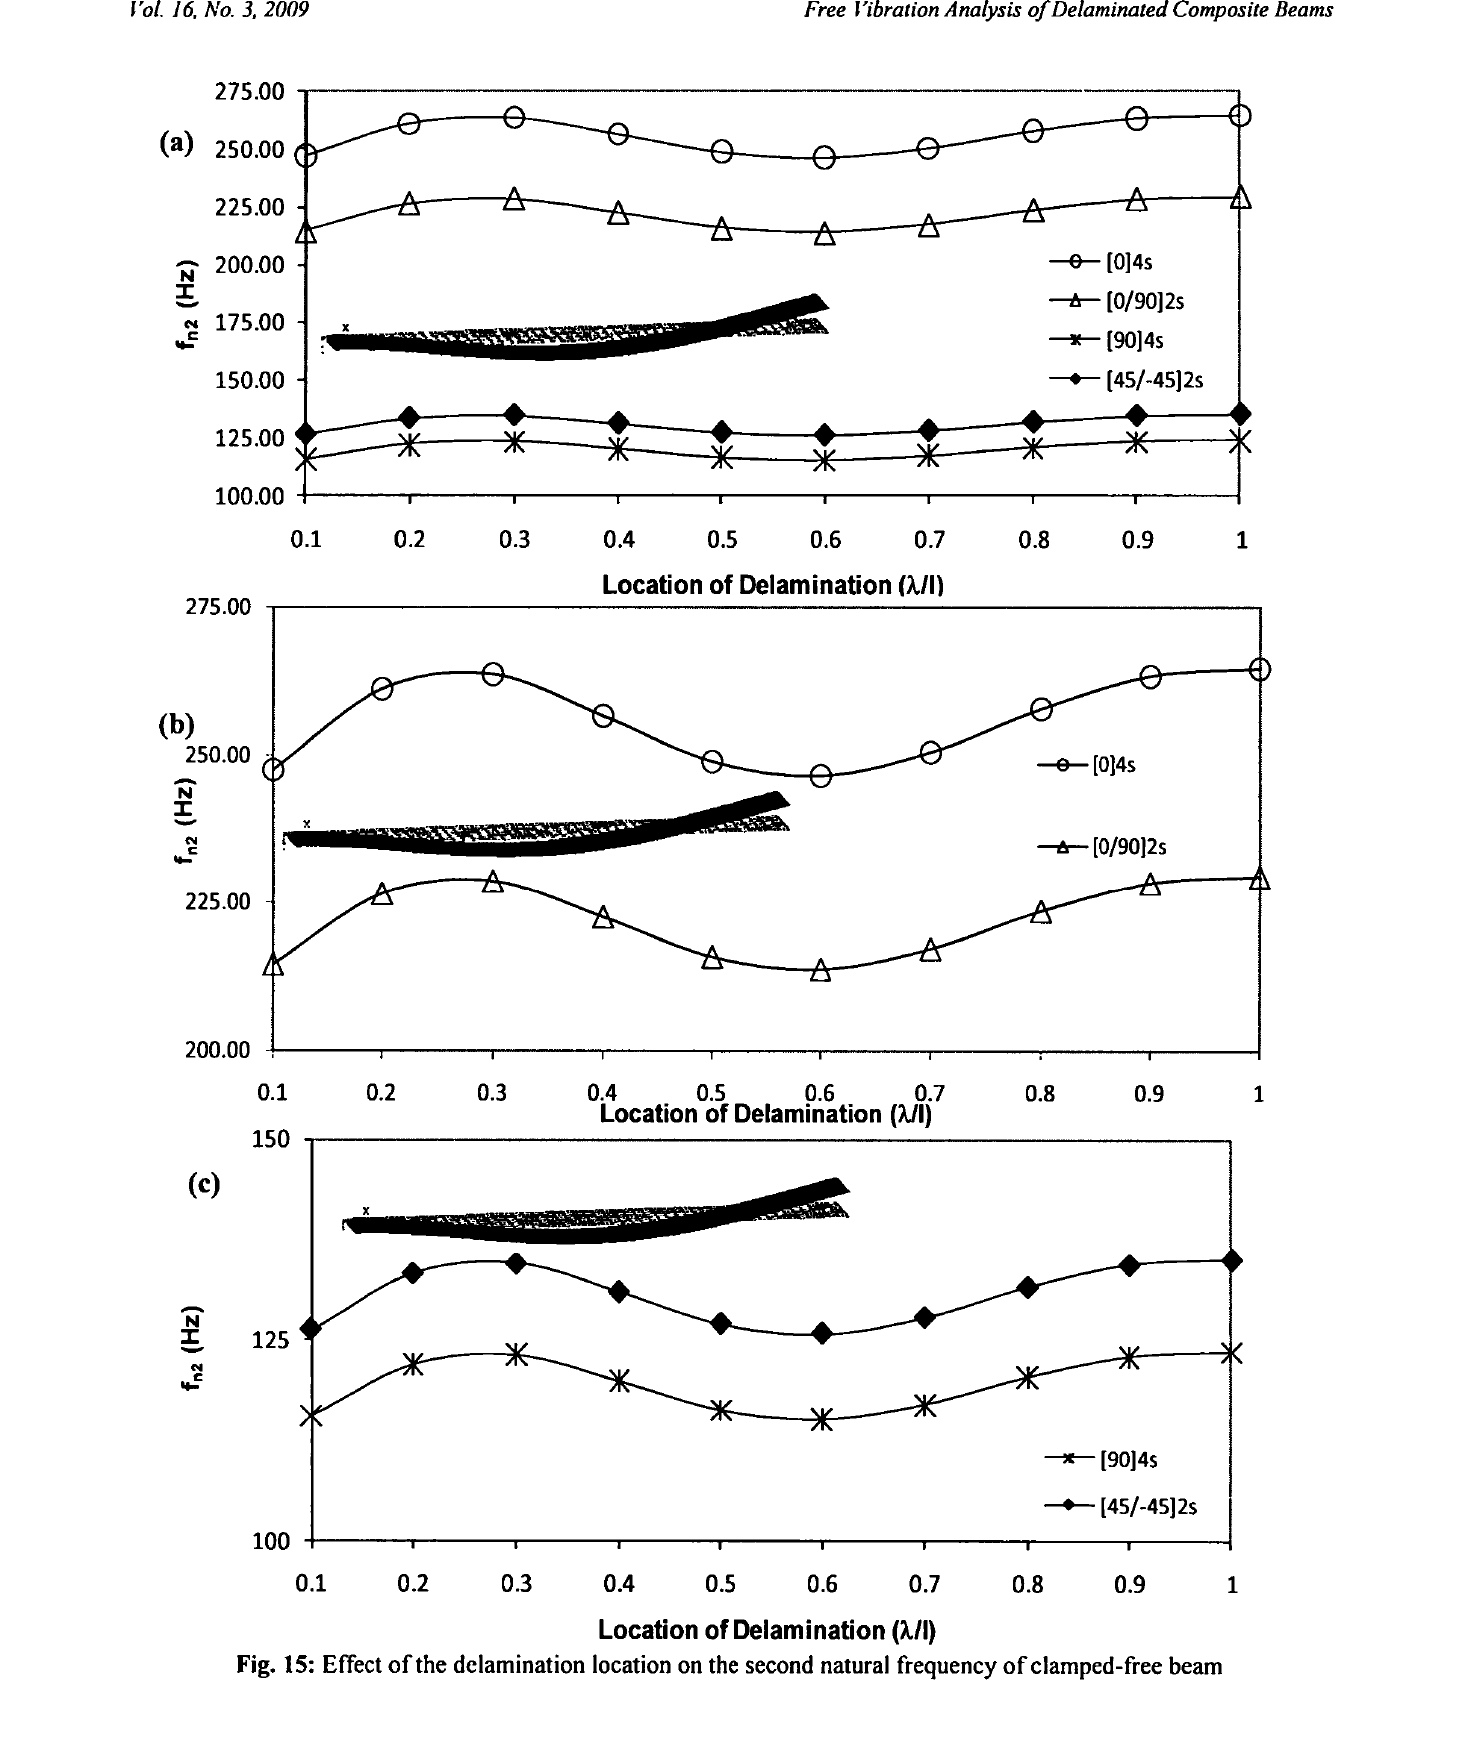
Fig. 15: Effect of the dclamination location on the second natural frequency of clamped-free beam